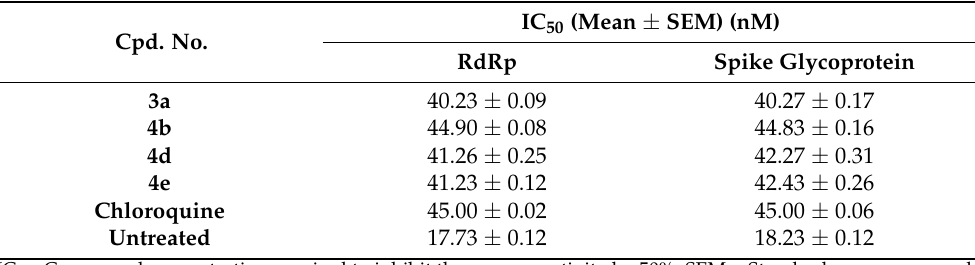
Table 3. Inhibition % of the compounds 3a – c , 4a – e , 5a – e , and Chloroquine as a reference drug. Cpd.